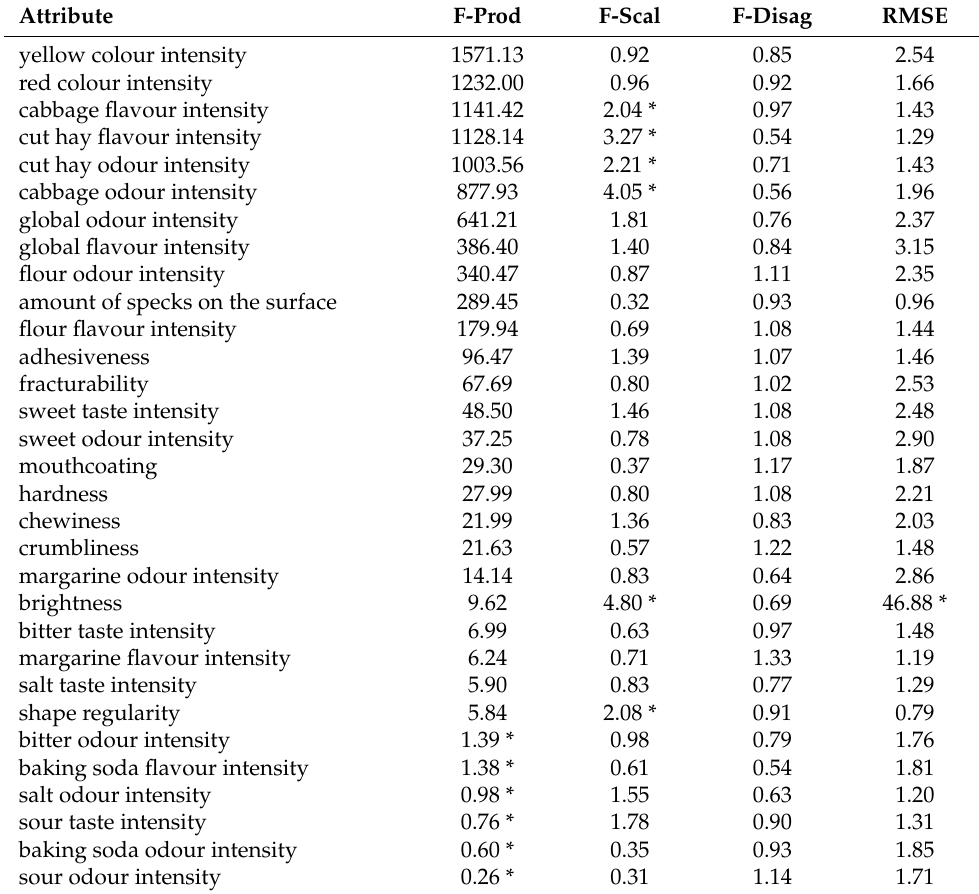
Table 8. Sensory panel performance MAM-CAP